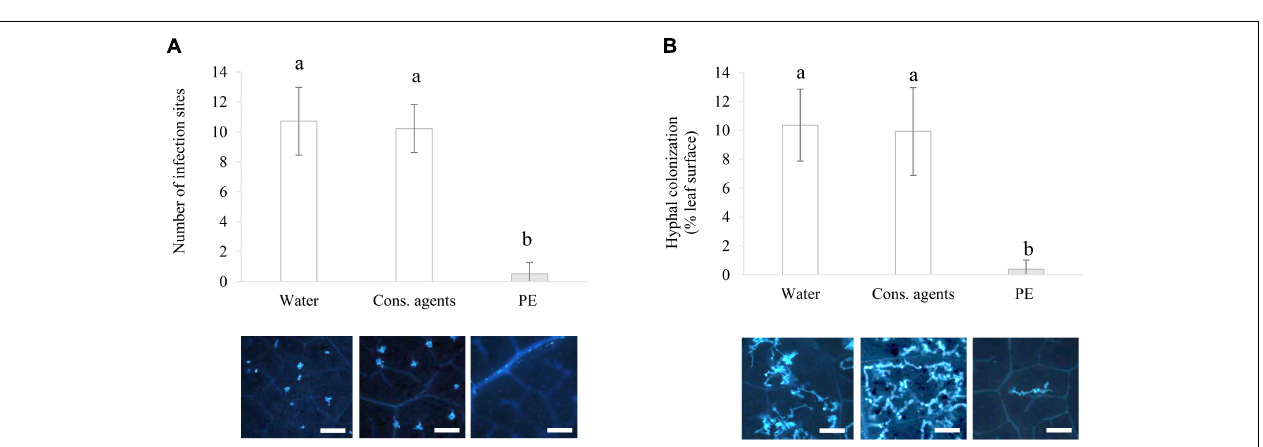
FIGURE 8 | Assessment of direct effect of PE on the early steps of P. viticola infection in planta . Plants were treated with 5 g L − 1 PE, or equal volumes of conserving agents or water, and were inoculated with P. viticola sporangia suspension (10 5 sporangia mL − 1 ) at 2 hpt. Aniline blue staining was performed to visualize: (A) the number of infection sites per observation field, counted at 24 hpi; and (B) the hyphal colonization surface (%) per observation field at 48 hpi, estimated by image analysis. Results correspond to the mean ± standard deviation of three independent biological repetitions. Significant differences ( p ≤ 0.05) were identified with Kruskal–Wallis coupled with Dunn’s multiple comparison test. Conditions with different letters are significantly different. Pictures presented hereby are the ones with the closest values to the mean. Scale bars represent 100 µ